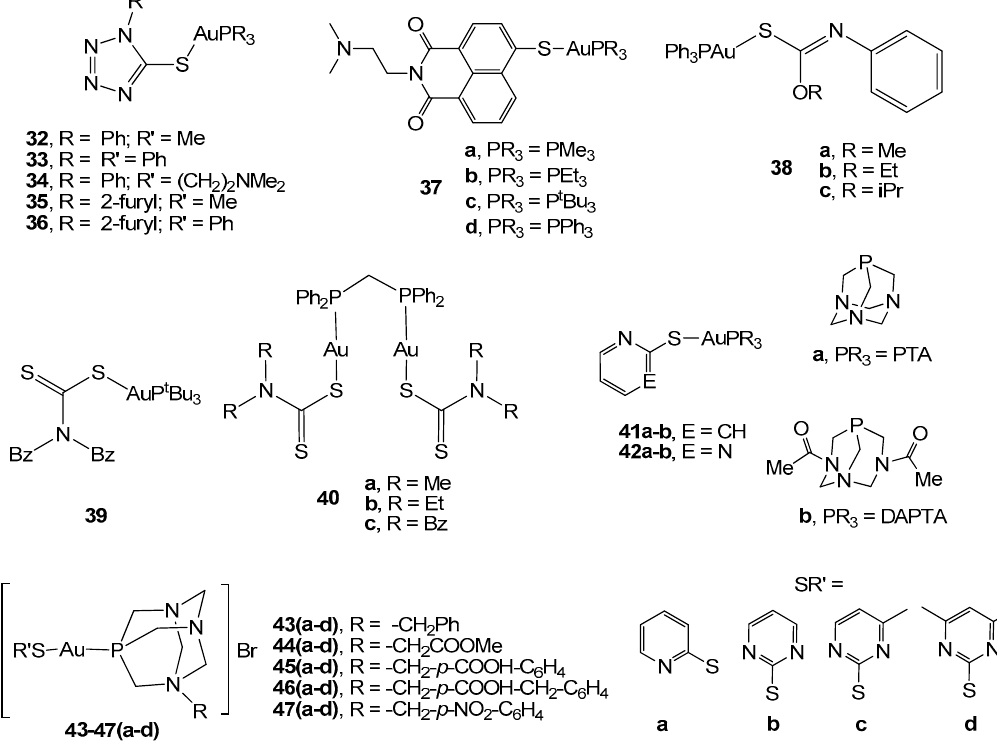
Figure 3. Thiolate phosphane gold(I) derivatives.